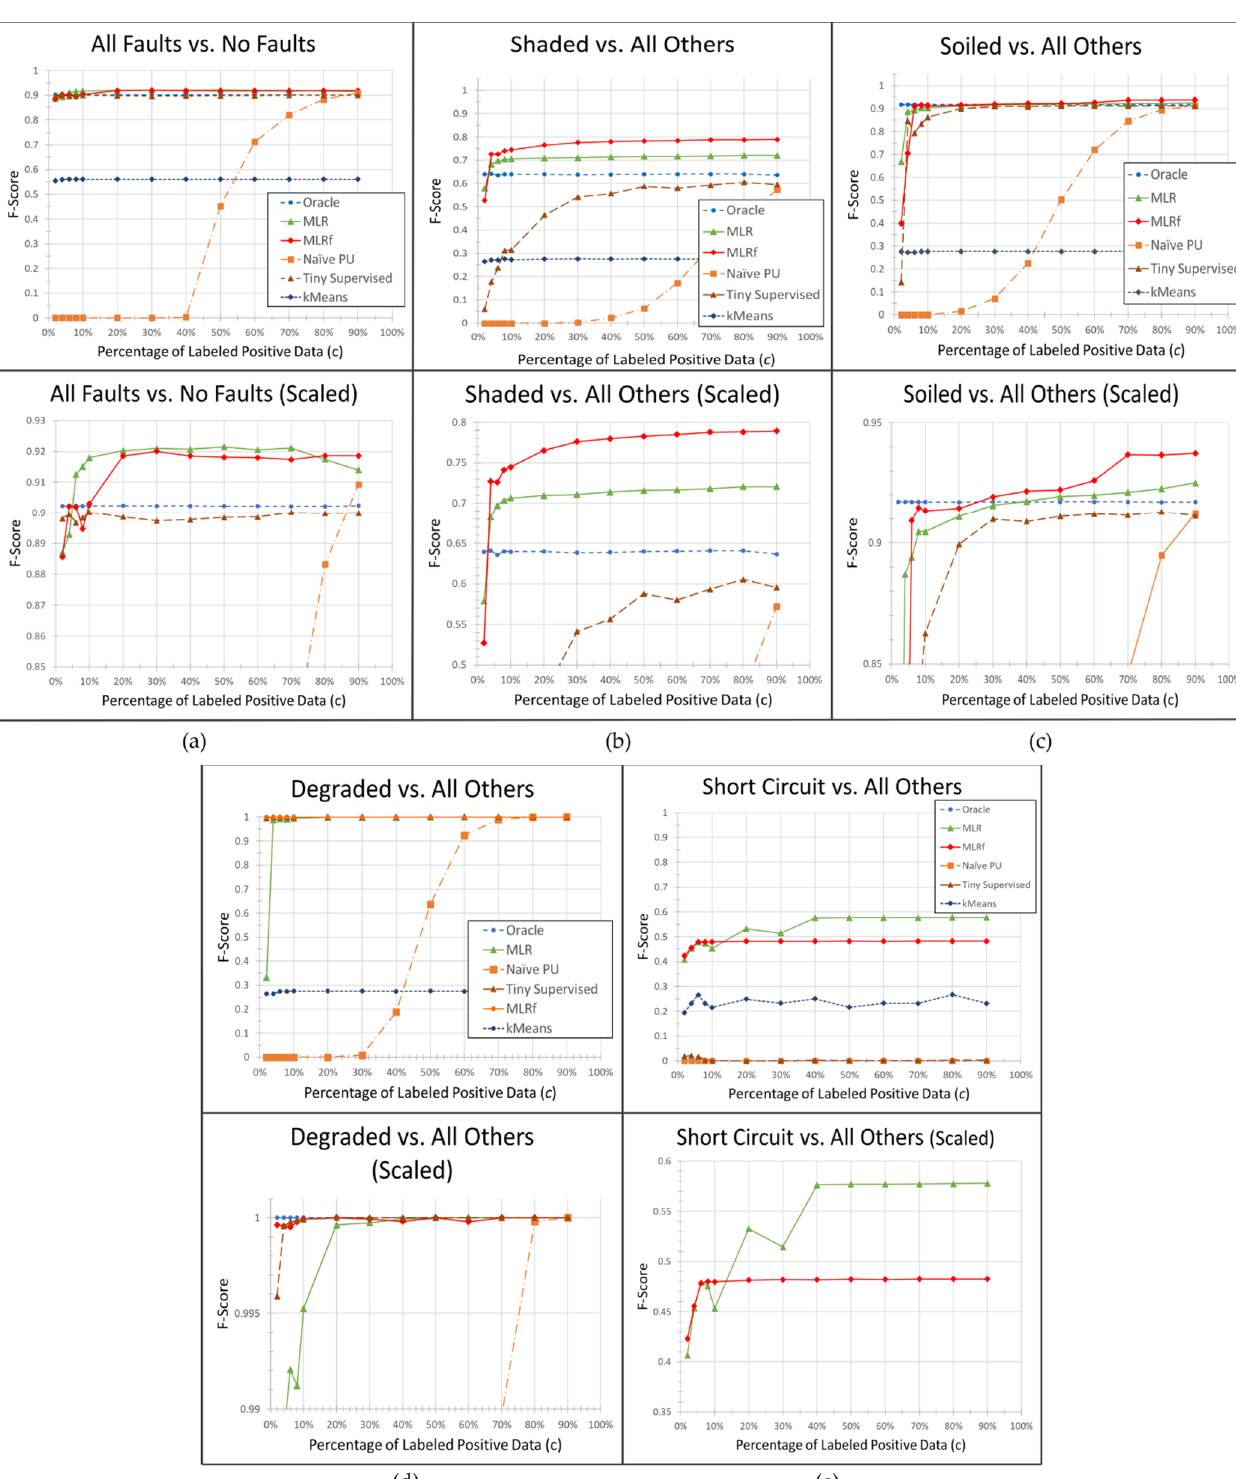
Figure 2. Algorithm results for each fault type: ( a ) General fault detection; ( b ) Shaded panels; ( c ) Soilage; ( d ) Degraded panels; ( e ) Short Circuit faults.